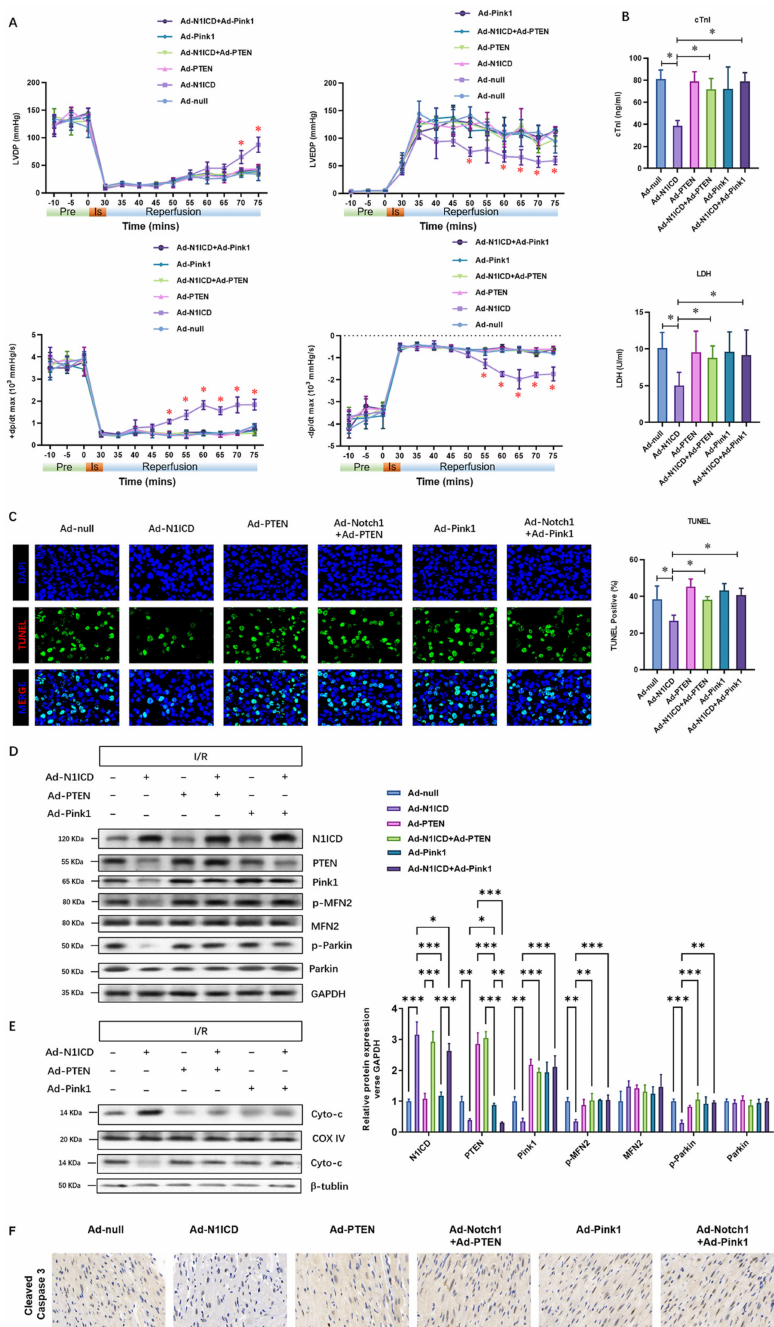
Figure 8. N1ICD protects against I/R injury via suppressing PTEN-Pink1-mediated mitochondrial dysfunction and mitophagy in vivo. ( A ), Representative traces and summarized data of LV pressure (LVP) during I/R in isolated rat hearts from indicated groups; ( B ) up panel: The level of cTnI was detected at the end of the reperfusion to assess myocardial injury; down panel: The activity of LDH was evaluated by electrochemiluminescence immunoassay; ( C ) representative pictures and quantitative results of TUNEL-stained cardiac sections are shown; ( D ) the regulatory molecules of mitochondrial fission and fusion, including Pink1, Parkin1, and MFN2, were analyzed; ( E ) the regulatory molecule of mitochondrial pathway apoptosis, indicated by cytochrome c release from mitochondria, was analyzed; ( F ) the expression of cleaved caspase 3 was analyzed by IHC; N = 5; * p < 0.05, ** p < 0.01, *** p < 0.001 versus indicated